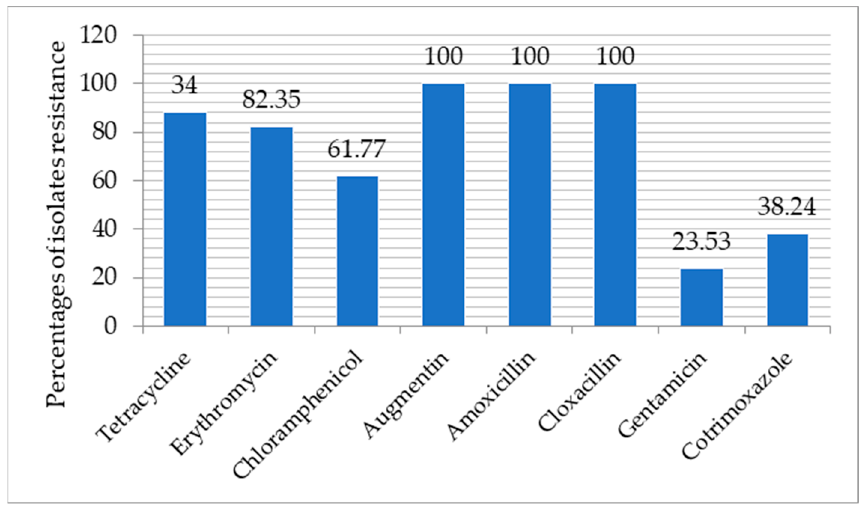
Figure 1. Percentage of S. aureus isolates resistant to common antibiotics (number of positive samples; n = 34), %.